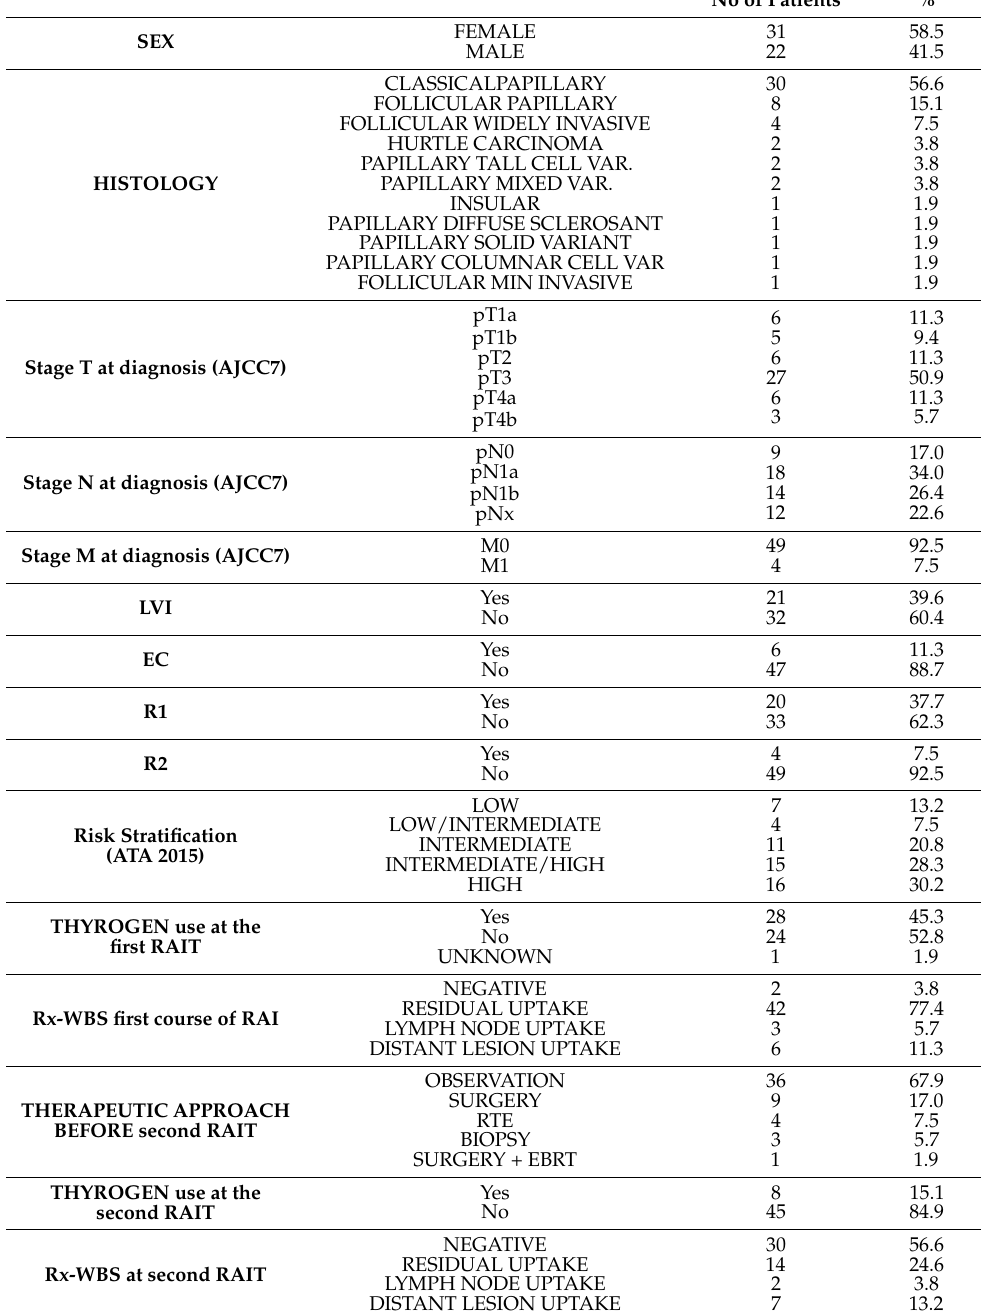
Table 1. Patient characteristics and clinical